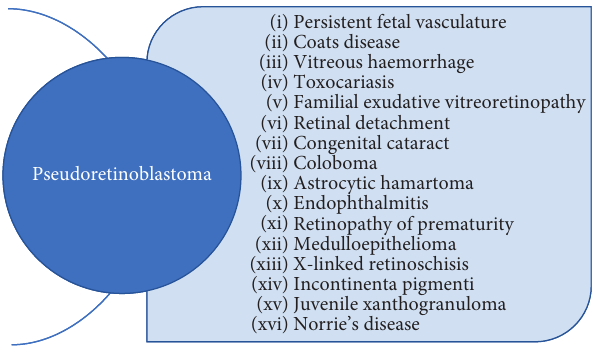
Figure 2: Differential diagnosis of retinoblastoma [2]. Table 3: Investigations performed in retinoblastoma and their findings [1, 11, 15].